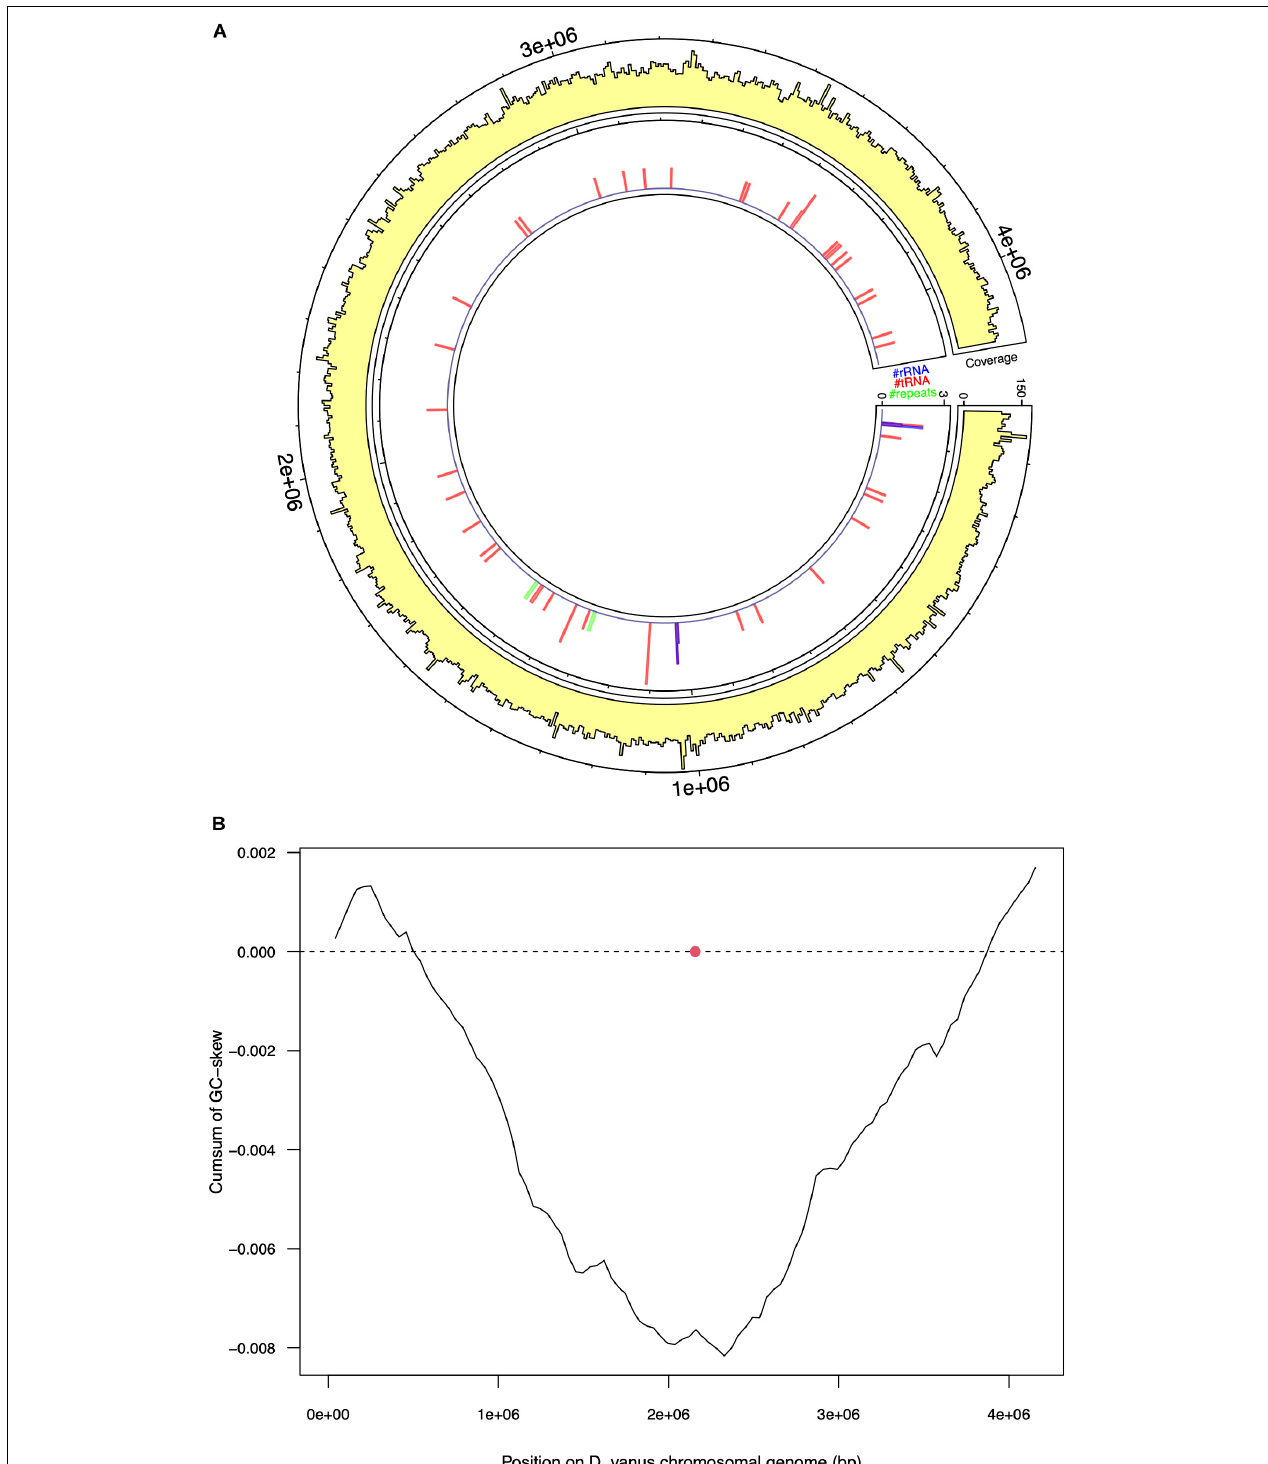
FIGURE 2 | Selected features of the structure and composition of the D. vanus chromosomal genome. (A) Circular visualization of the D. vanus chromosomal genome. The outmost tracks show the mean coverage estimated from mapping long reads to the genome, with per-base coverage binned into 5-kbp non-overlapping windows; the innermost track shows positions of rRNA genes (blue), tRNA genes (blue), and repeat regions (green) with counts obtained within the same 5-kbp windows as above. (B) Cumulative GC-plots showing the origin and terminus of replication, with the red closed circle showing the genomic position of the chromosomal replication initiator protein ( dnaA ) gene (CDGBEKEE_02056; Supplementary Data File 1 ).